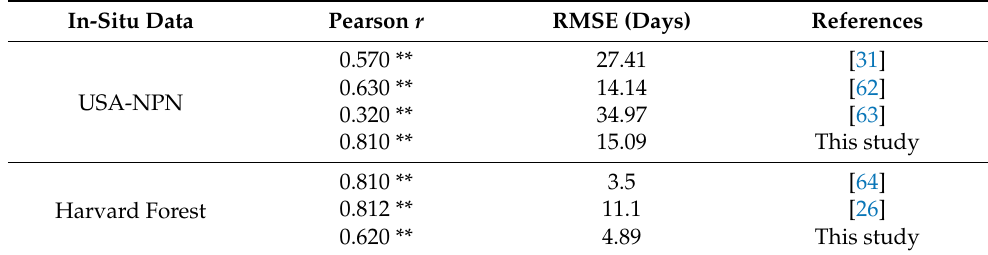
Table 1. The accuracy metrics related to the assessment on SOS retrieved from satellite data using in-situ